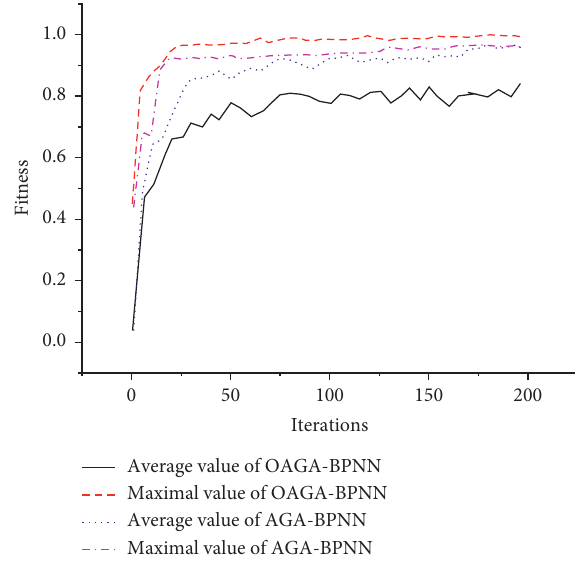
Figure 6: The changes and distribution curves of the maximal fitness and average fitness for the AGA-BPNN and